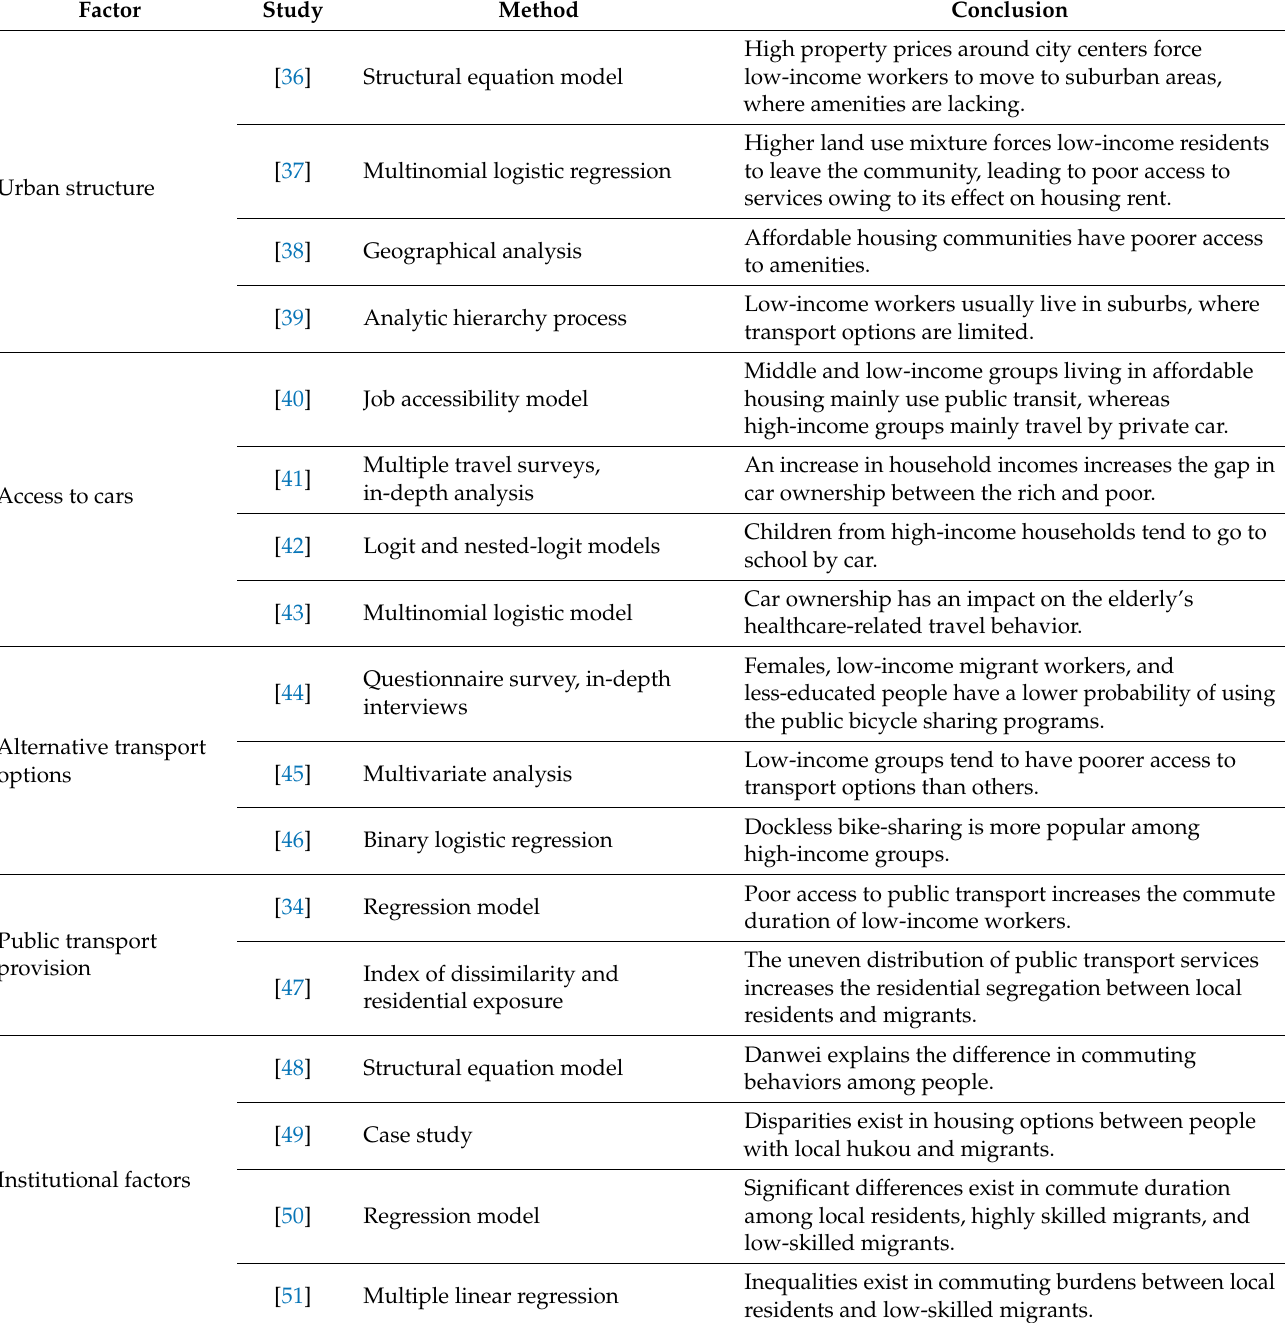
Table 1. Summary of causes of transport inequity in